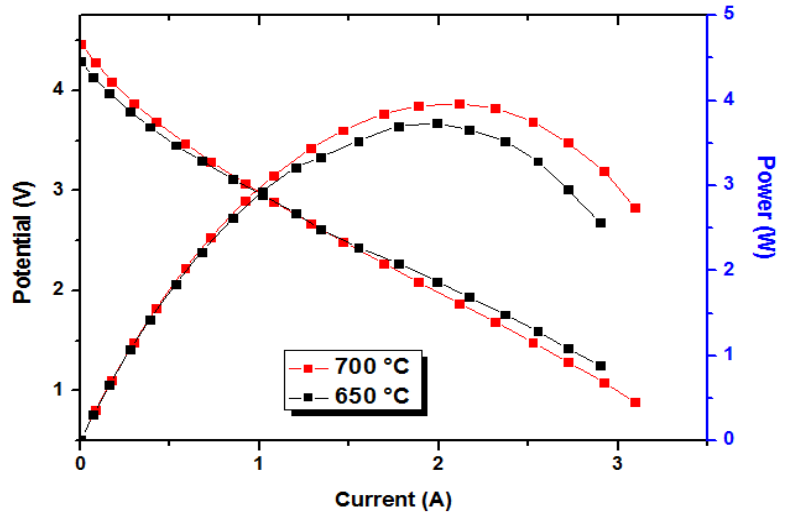
Figure 7. Current-potential and current-power curves of 2D SOFC stack at a flow rate of 900 mL/min of hydrogen and 1200 mL/min of air.